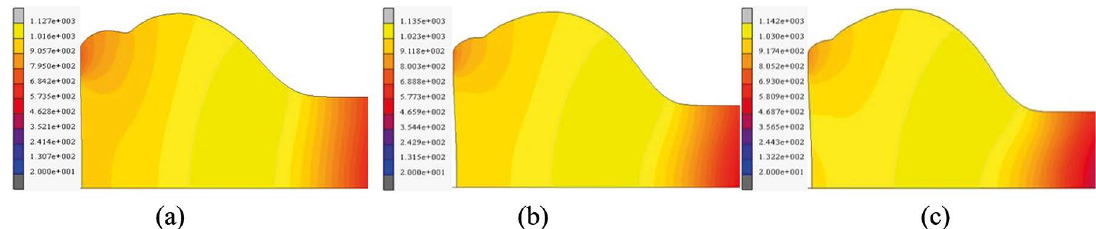
Figure 10: The shape of the workpiece after electric upsetting under different constant currents (a) 8042 A, (b) 8595 A, (c) 9550 A.